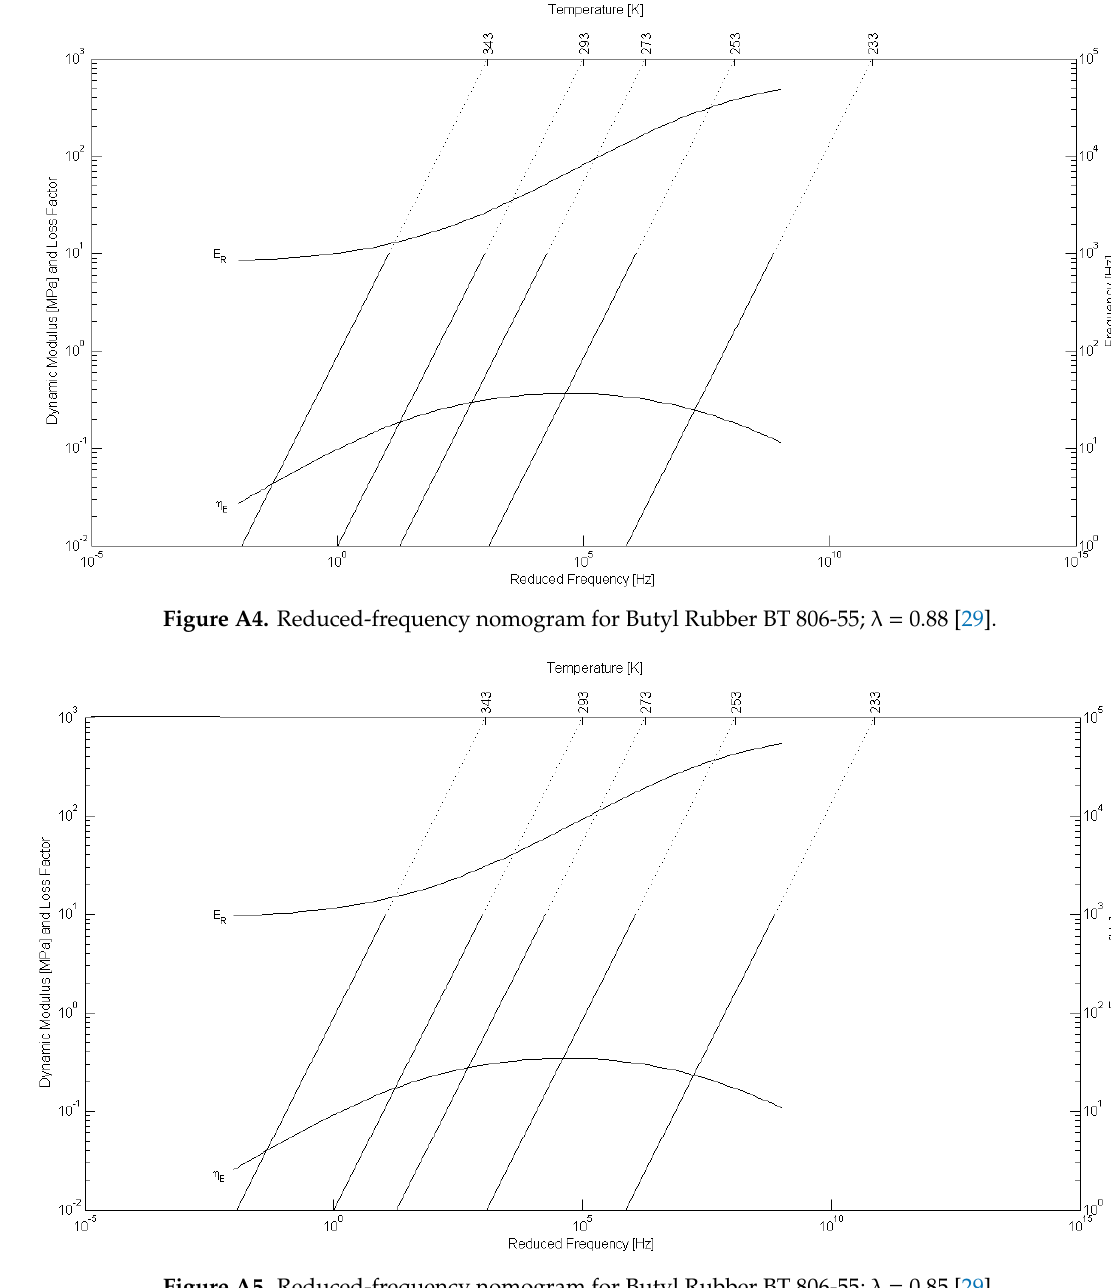
Figure A5. Reduced-frequency nomogram for Butyl Rubber BT 806-55; λ = 0.85 [29].